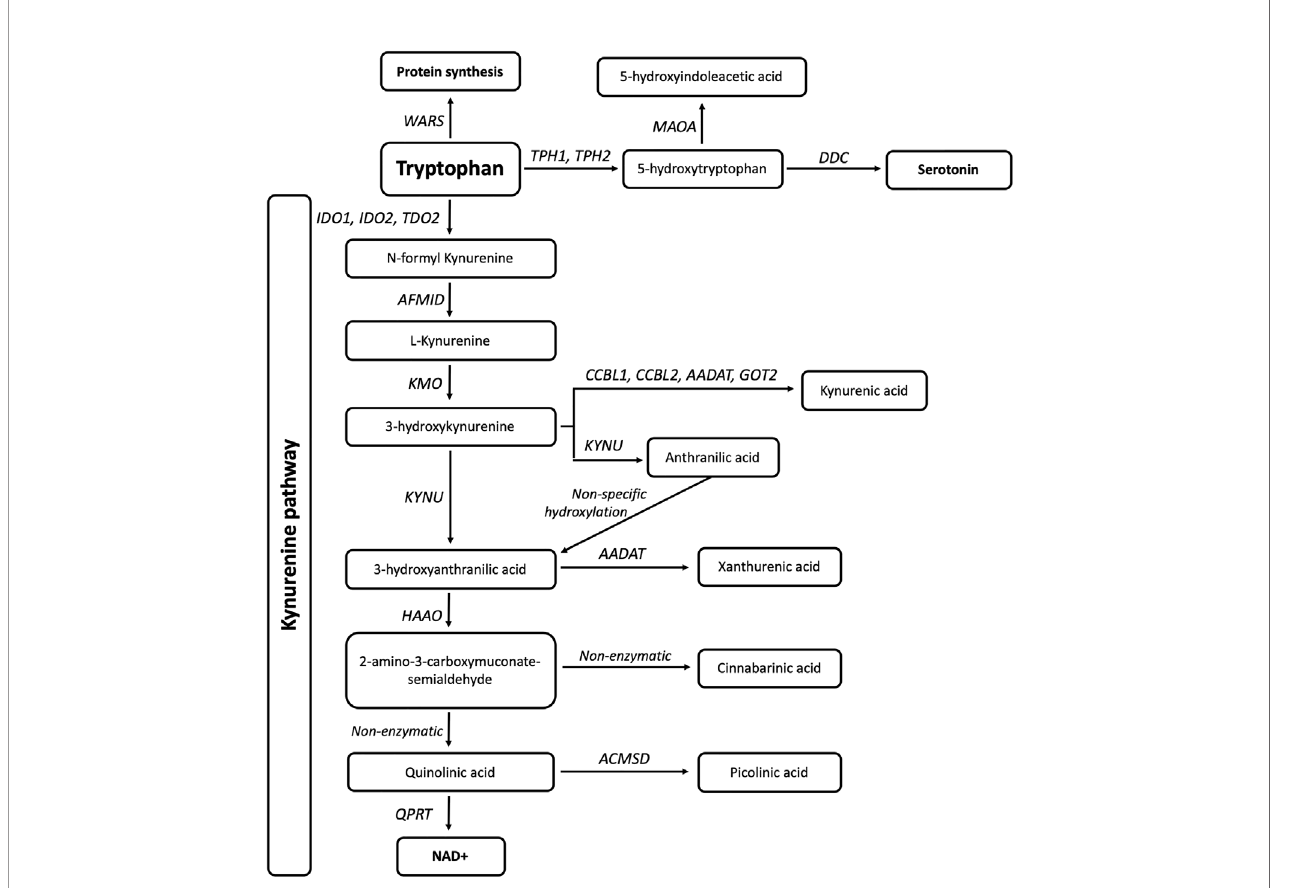
FIGURE 1 | Eighteen genes are involved in tryptophan metabolism and the kynurenine pathway. The gene WARS (cytoplasmic tryptophanyl-tRNA synthetase) is responsible for TRP incorporation into proteins, while TPH1 , TPH2 (Tryptophan Hydroxylases 1,2), MAOA (monoamine oxidase A), and DDC (Aromatic L-amino acid decarboxylase/dopa decarboxylase) are involved in serotonin synthesis. IDO1 , IDO2 (Indoleamine 2,3-Dioxygenase 1,2) and TDO2 (Tryptophan 2,3-Dioxygenase) are responsible for the initial and rate limiting step of the KP. This is followed by a molecular cascade to produce active metabolites and ultimately NAD, carried out by AFMID (Arylformamidase), CCBL1 , CCBL2 (Kynurenine aminotransferase 1,2), AADAT (Aminoadipate Aminotransferase), GOT2 (Glutamic-Oxaloacetic Transaminase 4), KMO (Kynurenine 3-Monooxygenase), KYNU (Kynureninase), HAAO (3-hydroxyanthranilate 3,4-dioxygenase), ACMSD (2-amino-3-carboxymuconate- semialdehyde decarboxylase), and QPRT (Quinolinate